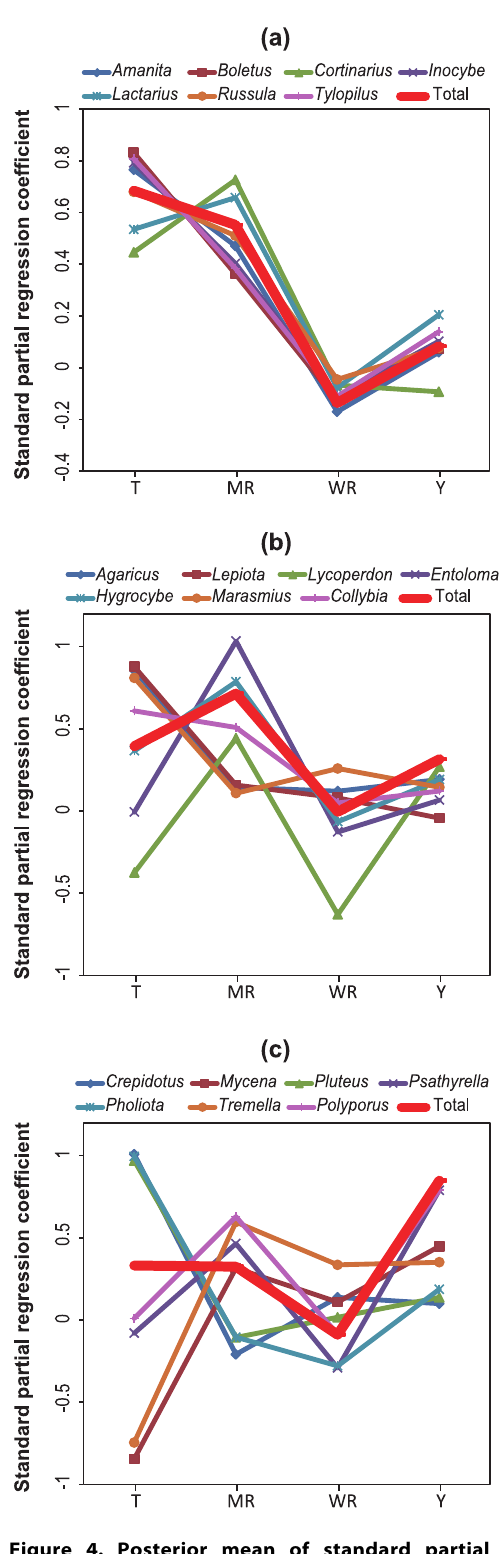
Figure 4. Posterior mean of standard partial regression coefficients when the number of fruiting species in ectomycor- rhizal (ECM) (a), litter-decomposing (b), and wood-decompos- ing fungal genera was regressed against monthly temperature (T), monthly accumulated rainfall (MR), weekly accumulated rainfall (WR), and number of elapsed years (Y). A positive regression coefficient value indicates positive effects on the number